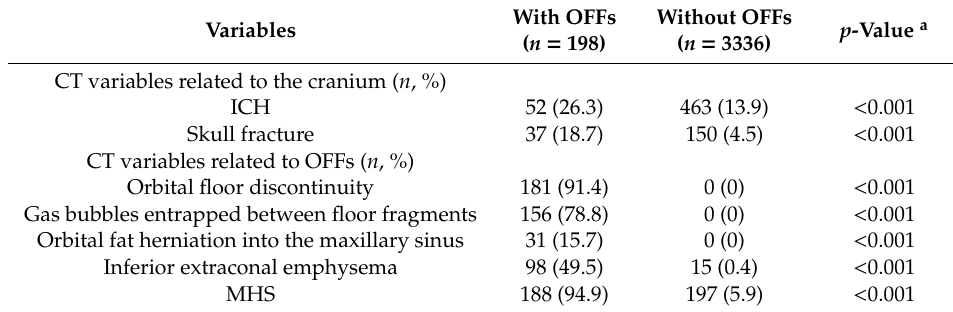
With OFFs Without OFFs ( n = 198) ( n = 3336)